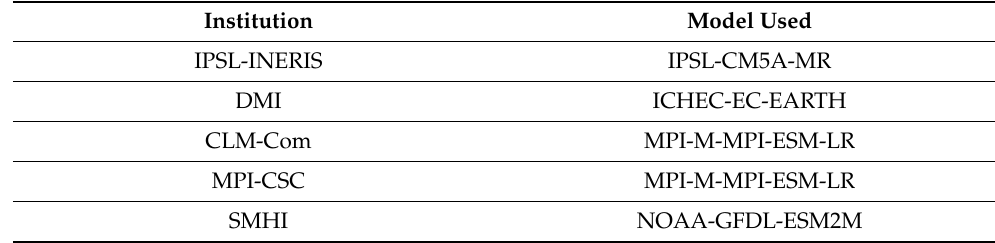
Table A2. List of the CORDEX model simulations used in the